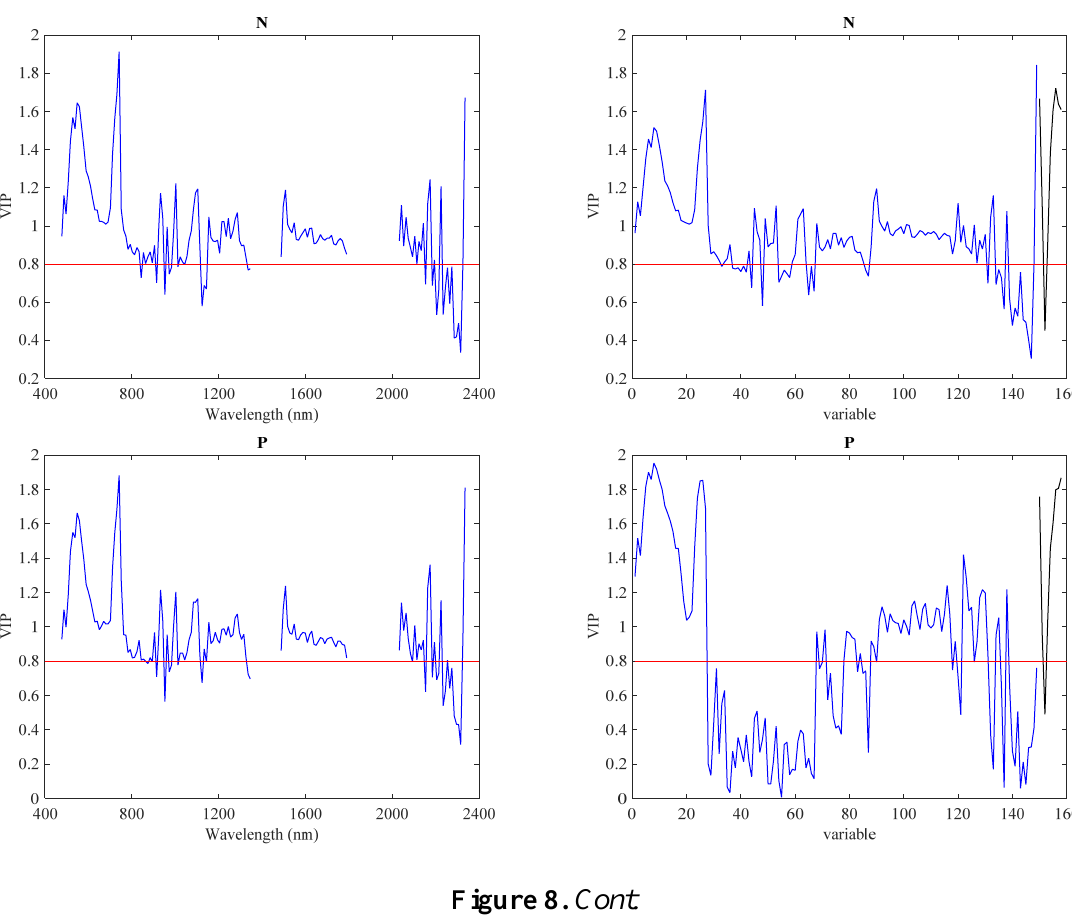
Figure 7. Standardized coefficients for the partial least squares (PLS) regression predictive models. Left column shows the coefficients for the models derived using only IS data and right column shows the coefficients for the models using IS and LiDAR data together for N, P, K, Ca and Mg, respectively. The black line in the right column graphs represents LiDAR data. The x-axis in the right column graphs represents the same 149 wavelengths in the left column graphs and additionally the LiDAR data. The red line indicates